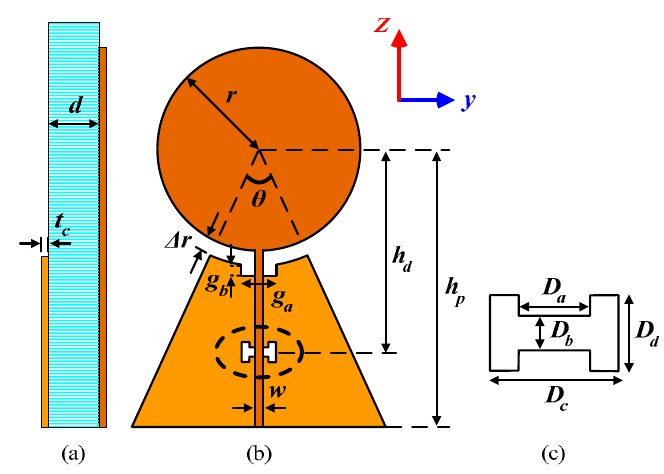
Figure 1. Schematic for the proposed single port wideband disk antenna: ( a ) cross-sectional view; ( b ) top view; and ( c ) etched ground dimensions.